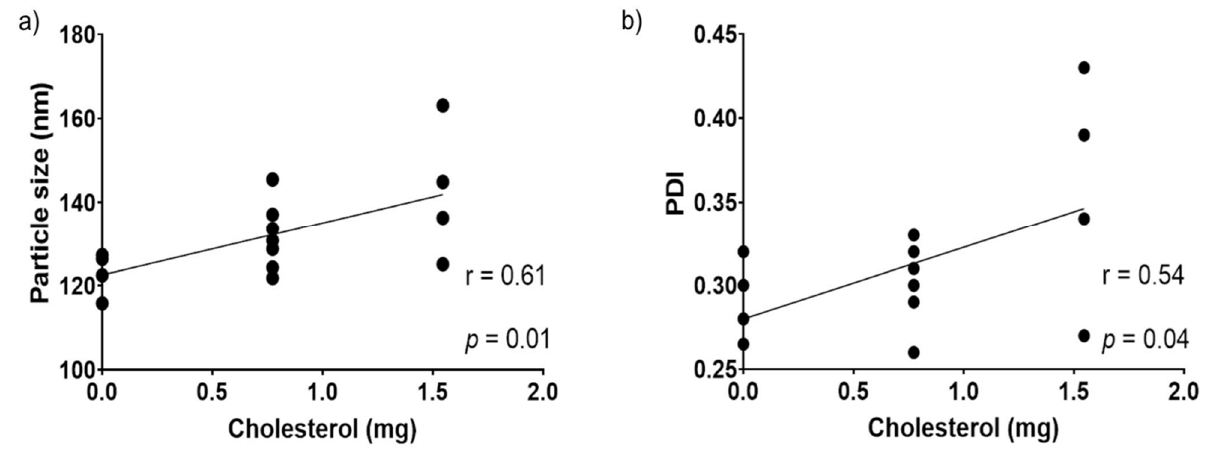
Figure 5. ( a ) Correlation between cholesterol and particle size; ( b ) correlation between cholesterol and PDI.